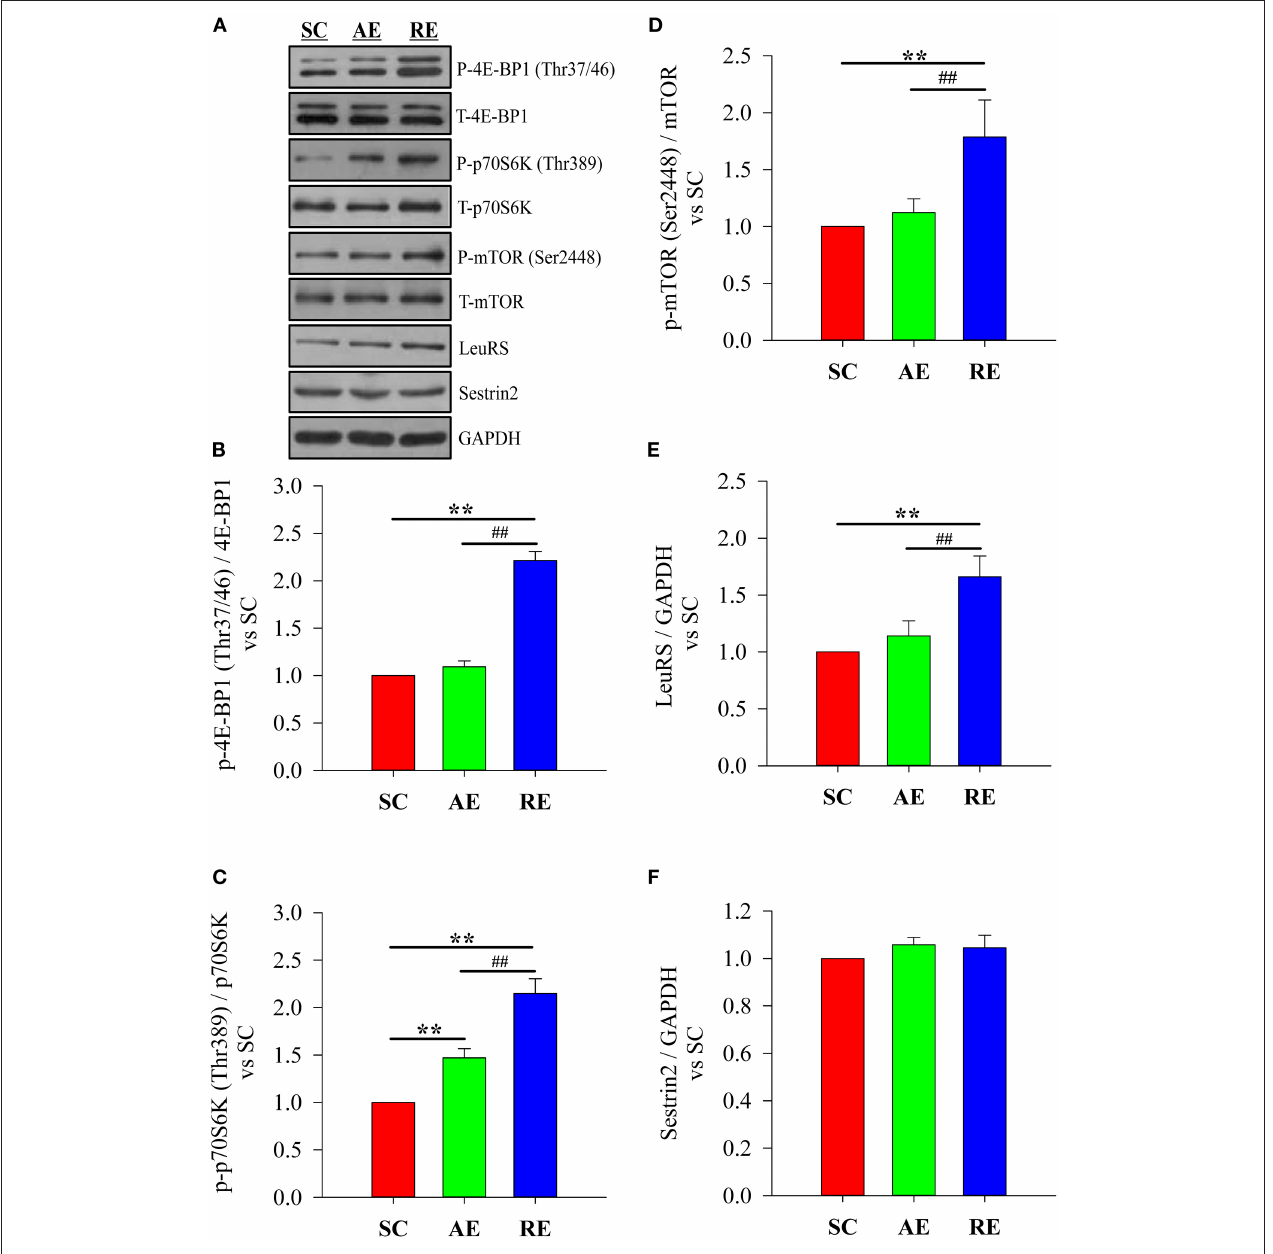
FIGURE 3 | Effects of exercise on protein expression with relation to leucine-sensing. (A) blotting, (B) phosphorylation state of 4E-BP1 (Thr37/46), (C) phosphorylation state of p70S6K (Thr389), (D) phosphorylation state of mTOR (Ser2448), (E) relative expression of LeuRS and (F) relative expression of Sestrin2. SC, sedentary control group; AE, aerobic exercise training group; RE, resistance training exercise group. Data were expressed relative to the SC group. The expression of LeuRS and Sestrin2 were normalized to GAPDH. The phosphorylation state of mTOR signaling was calculated as the ratio of phosphorylated protein to total. ** P < 0.01 vs. the SC group; ## P < 0.01 vs. the AE